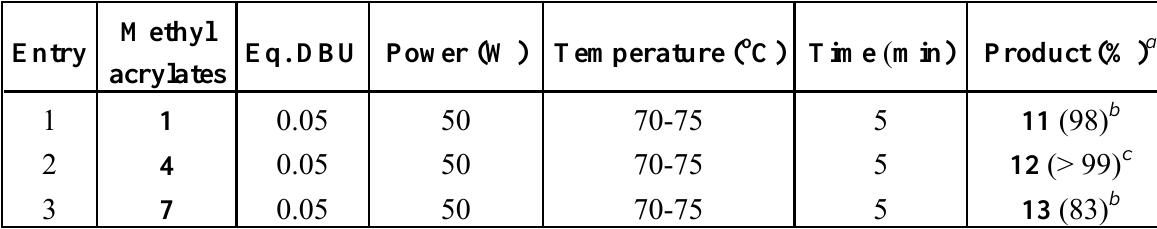
a Yield after their purification by column chromatography. b Diastereomeric ratio was obtained